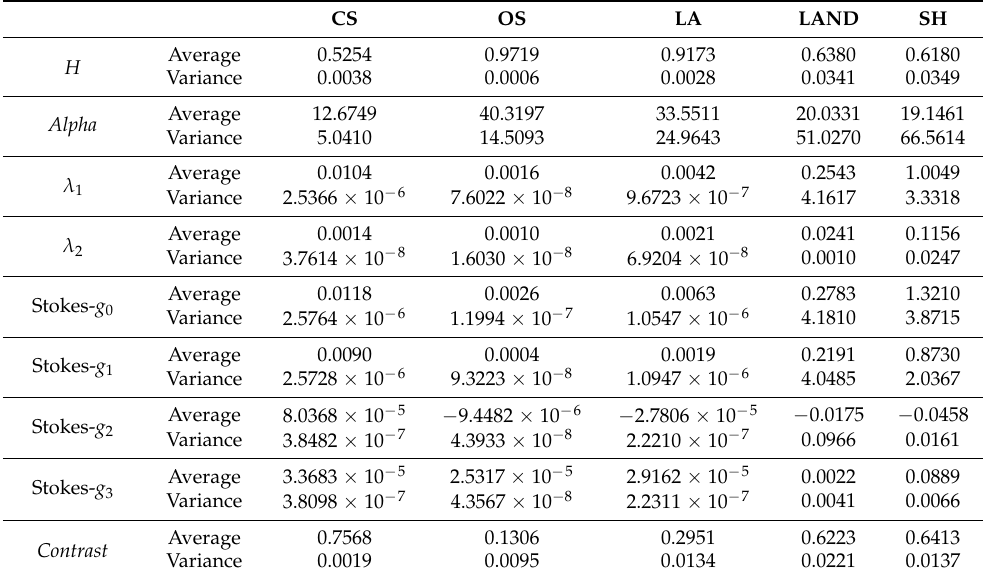
Table 5. Average and variance of different polarized parameters.